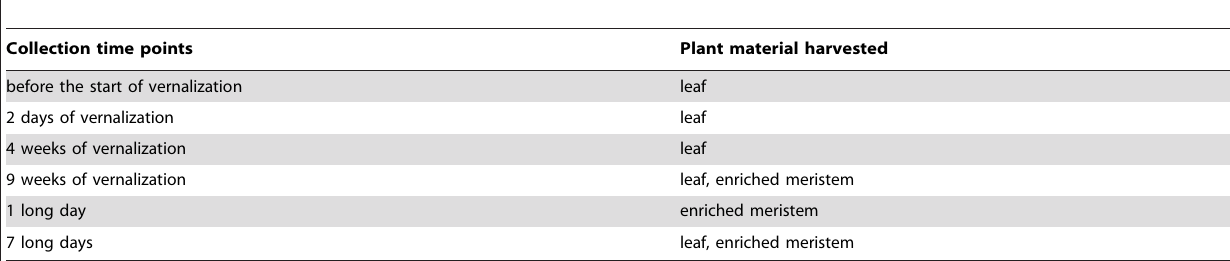
Table 1. Plant material harvested from the Falster and Veyo genotypes and sample collection time